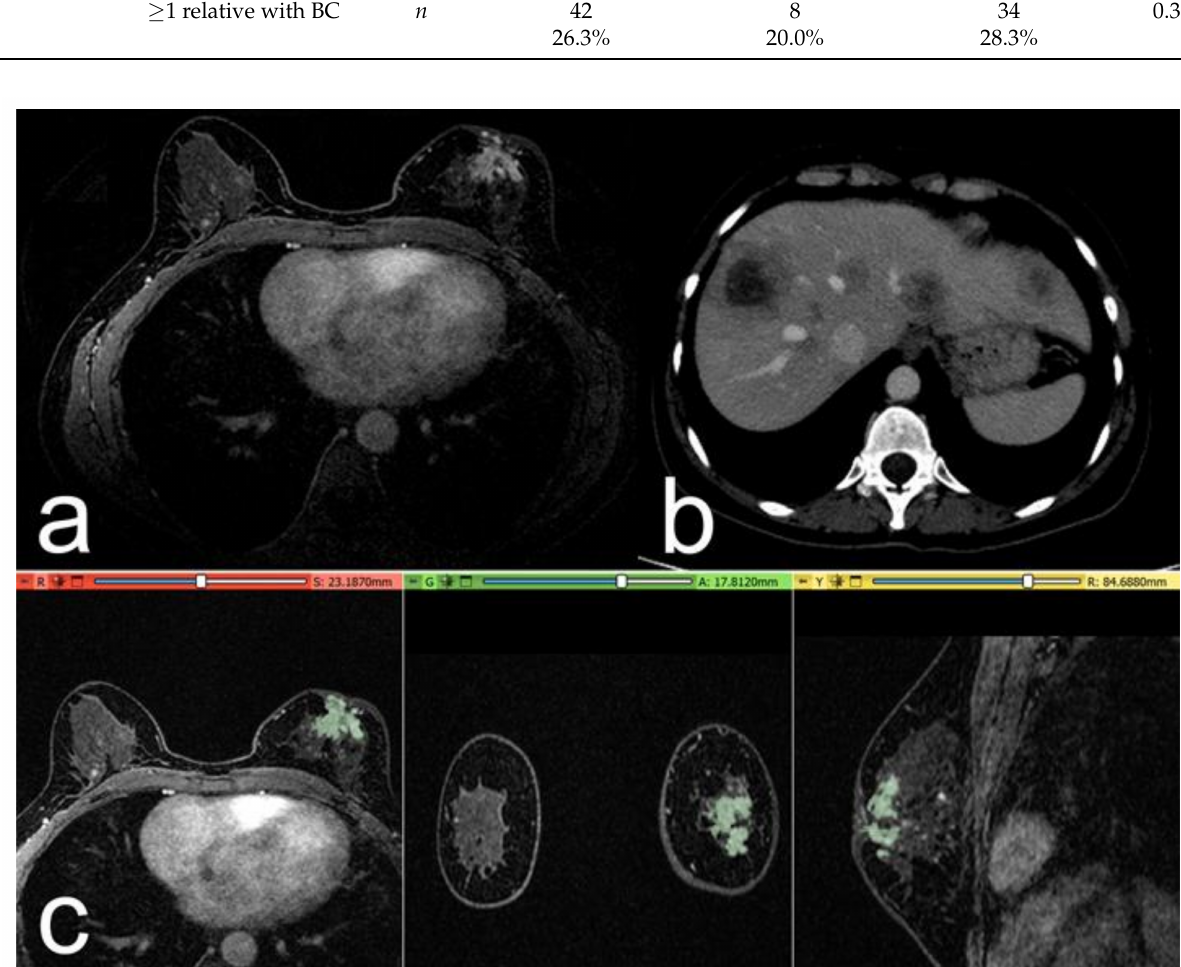
Figure 3. Case of a 52-year-old woman with a G3 triple negative invasive ductal carcinoma, Ki-67 of 30%. ( a ) The post-contrast image shows a retroareolar irregular non-mass-enhancing lesion in the left breast. ( b ) At 1-year follow-up: post-contrast axial CT image, with some metastatic nodules in the liver parenchyma. ( c ) Representation of the extraction of the segmentation